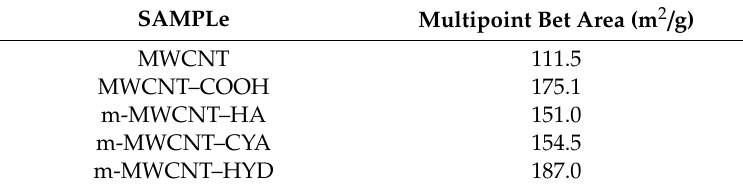
Table 1. BET results for MWCNT, MWCNT–COOH, m-MWCNT–HA, m-MWCNT–CYA, and m- BET results for MWCNT, MWCNT–COOH, m-MWCNT–HA, m-MWCNT–CYA, MWCNT–HYD. and